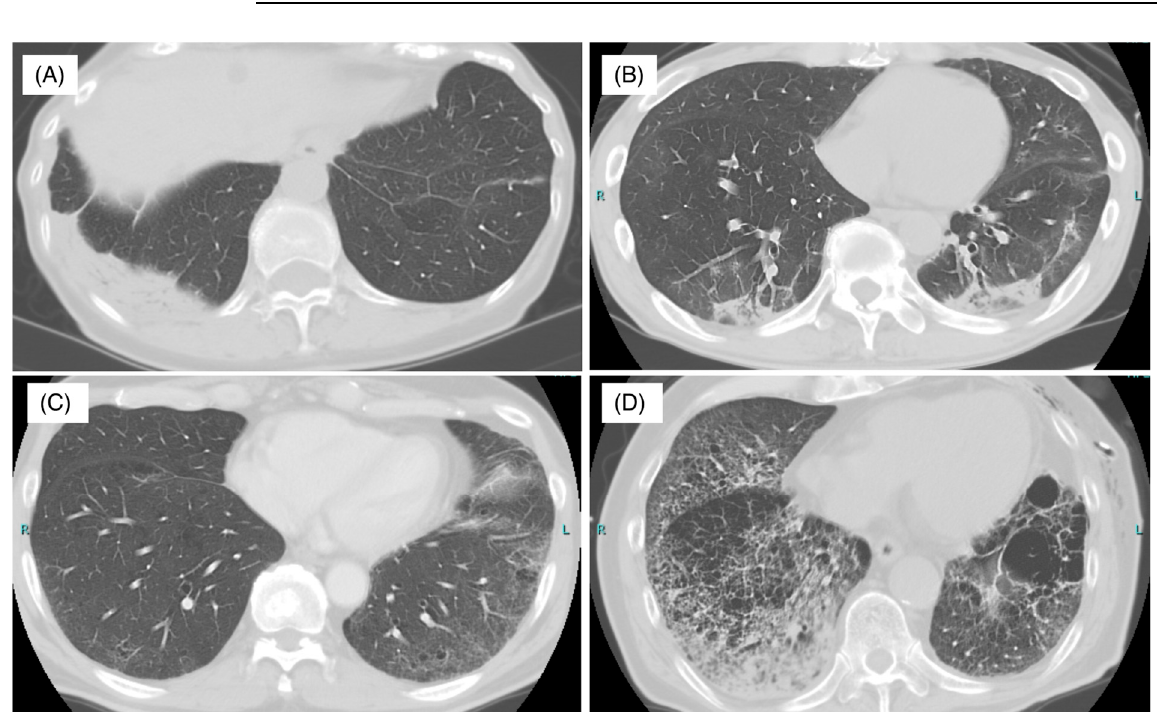
Figure 2. Radiologic features of immune-checkpoint inhibitor-related pneumonitis. ( A ) Organizing pneumonia (OP) pattern in a patient with stage IV renal cell carcinoma treated with nivolumab. An axial chest CT image obtained 4 months after nivolumab therapy shows an infiltration shadow on the peripheral pleural side, predominantly in the lower lung field. ( B ) A nonspecific interstitial pneumonia (NSIP) pattern in a patient with stage IV bladder cancer treated with nivolumab. An axial chest CT image obtained 11 months after nivolumab therapy shows bilateral lower lobe ground-glass opacities and reticular opacities with regions of subpleural sparing. ( C ) A hypersensitivity pneumonitis (HP) pattern in a patient with stage IV lung adenocarcinoma treated with pembrolizumab. An axial chest CT image obtained 5 months after pembrolizumab therapy shows diffuse, subtle ground-glass opacities. ( D ) A diffuse alveolar damage (DAD) pattern in a patient with stage IV lung adenocarcinoma treated with pembrolizumab. An axial chest CT image obtained 5 months after pembrolizumab therapy shows diffuse ground-glass opacities and consolidation. All images were collected at Kyushu University.